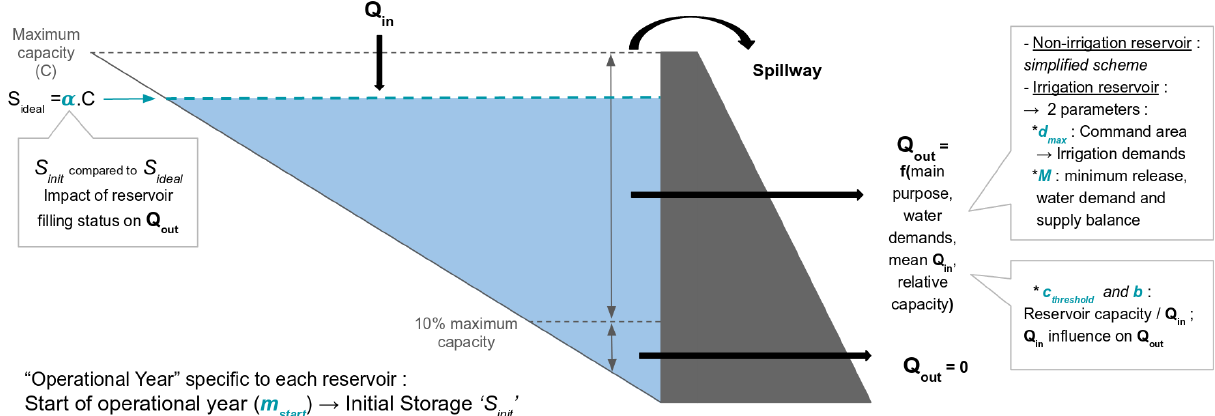
Figure 1. Schematic representation of the DROP model showing its six parameters (in blue): m start defines the start of the reservoir oper- ational year. α sets the ideal filling rate of the reservoir to be reached at each starting month of the year. The remaining four parameters are used in dam release computation: d max and M , operating only in irrigation reservoirs, set the control area of the reservoir (and therefore irrigation water demands) and the minimum release to be provided, respectively. c threshold and b , on the other hand, account for inflow pattern influence in reservoirs with low relative storage capacity to inflow (i.e., run-of-river